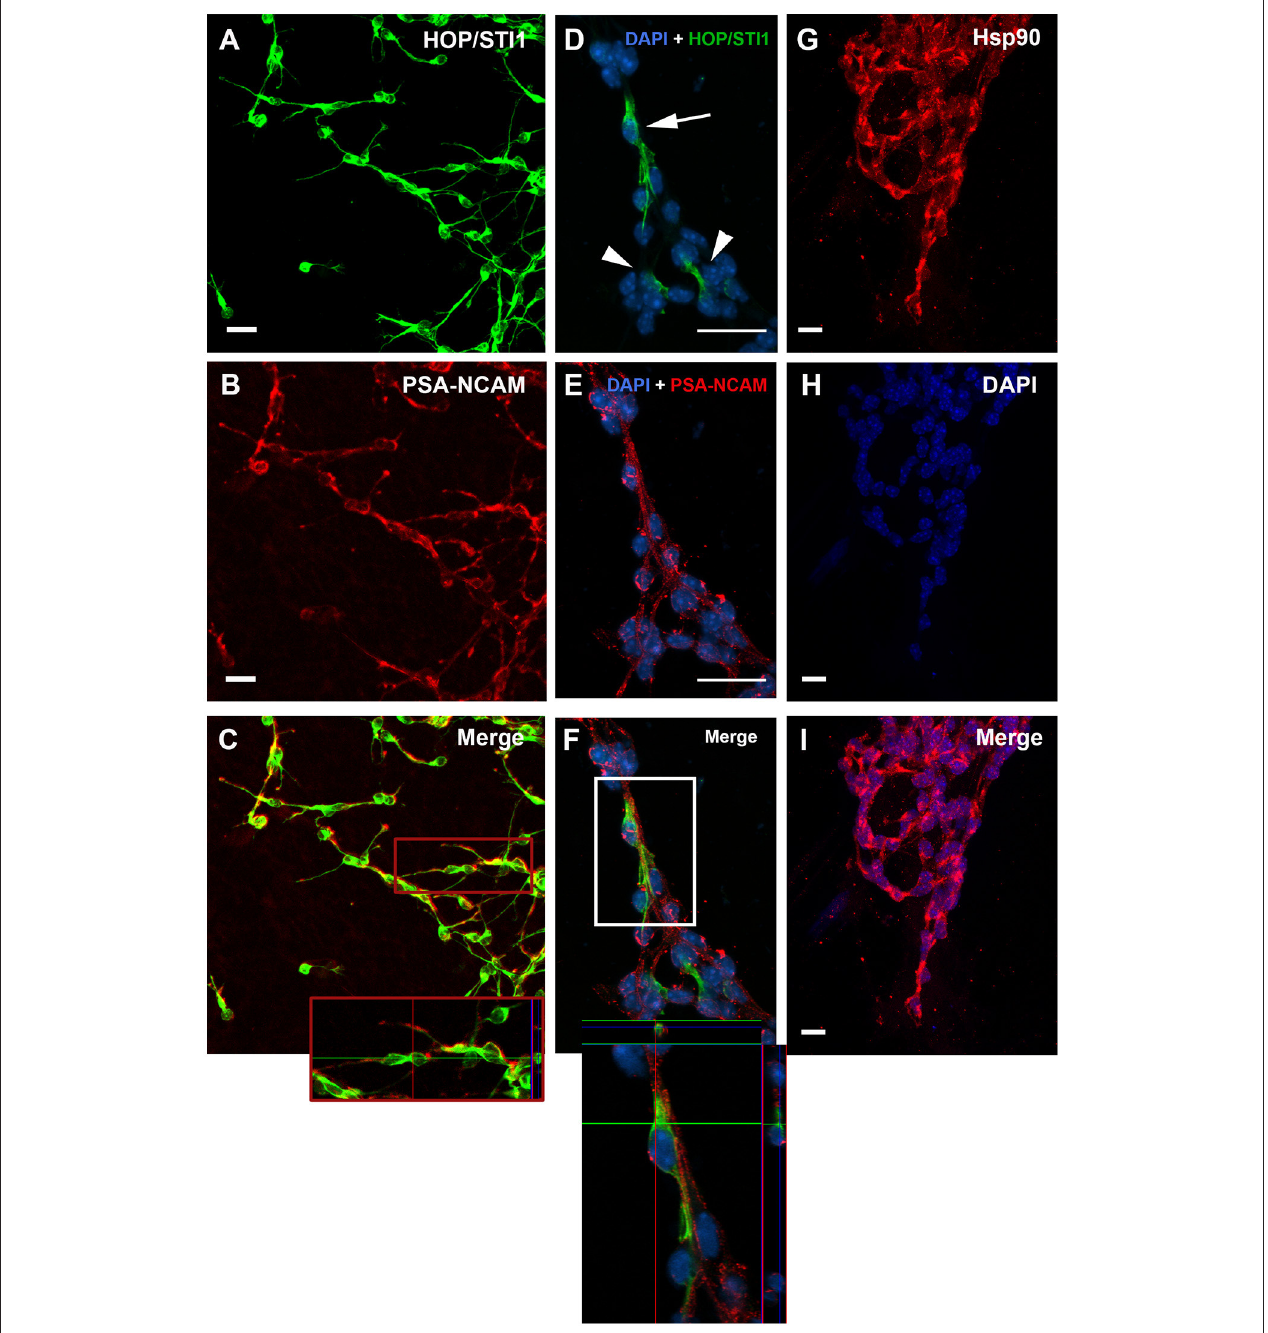
FIGURE 2 | HOP/STI1 and Hsp90 are both expressed by SVZ migratory neuroblasts. (A) Migratory cells originating from SVZ explants immunolabeled against anti-HOP/STI1 antibody reveal an ubiquitous expression pattern. (B) PSA-NCAM expression is used to characterize neuroblasts from the SVZ. (C) Double labeling indicates that HOP/STI1 expressing cells are neuroblasts. Inset shows an orthogonal section depicting a chain of HOP/STI1 + /PSA-NCAM + cells. (D) HOP/STI1 is expressed predominantly in the cellular processes in non-permeabilized SVZ cultures (arrowheads). Only few cells within the migratory chains exhibit perinuclear expression (arrow). (E) Analysis of PSA-NCAM expression characterizes these cells as neuronal precursors that co-express HOP/STI1, as can be seen in more detail in an orthogonal section ( F , Inset). In (G) , chains of migratory cells are also immunolabeled against anti Hsp90. In (H) , Dapi nuclear staining demonstrates these cells organized as chains, which is a hallmark of SVZ neuroblasts. Nuclear staining and Hsp90 expression are both depicted in the merge in (I) . Scale bars: (A,B) 20 µ m, (D,E) 20 µ m, and (G–I) 10 µ m.